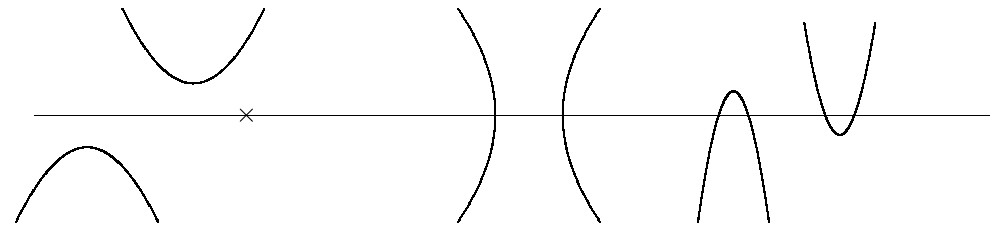
axis. Transitions from the form (a) or (c) to form r